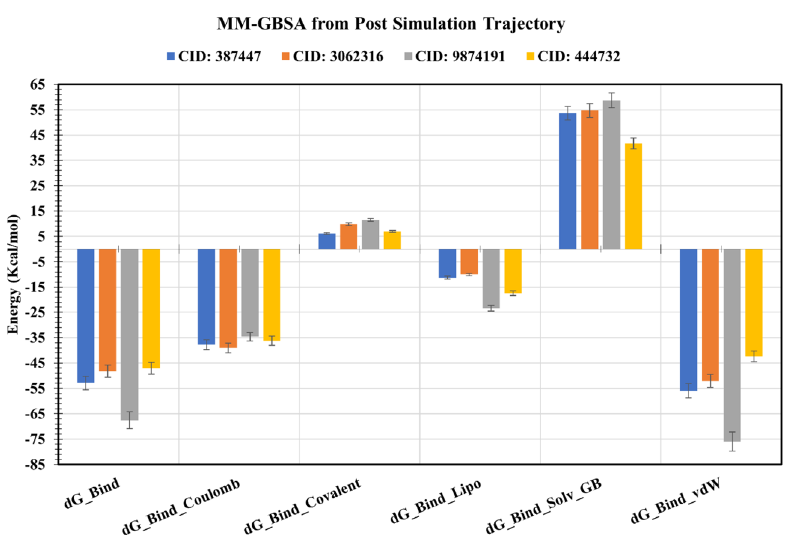
Figure 11. Representing different energy components and net MM/GBSA binding free energy (kcal/mol) and standard deviation values generated from extracted snapshots of MCM7 protein in complex with selected